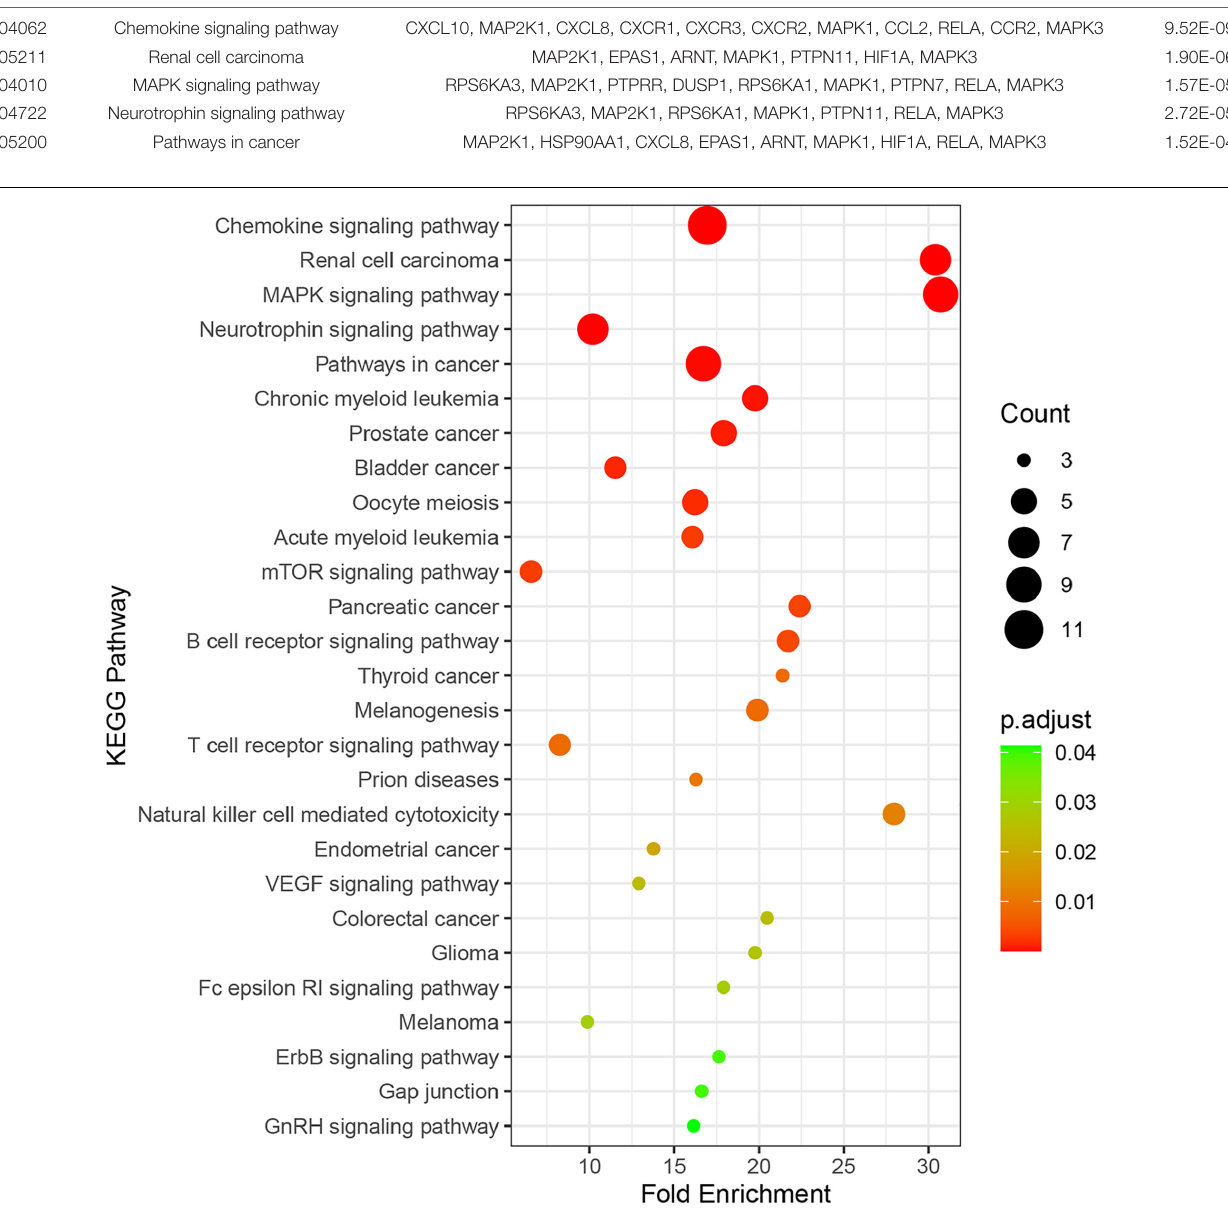
Frontiers in Cell and Developmental Biology |